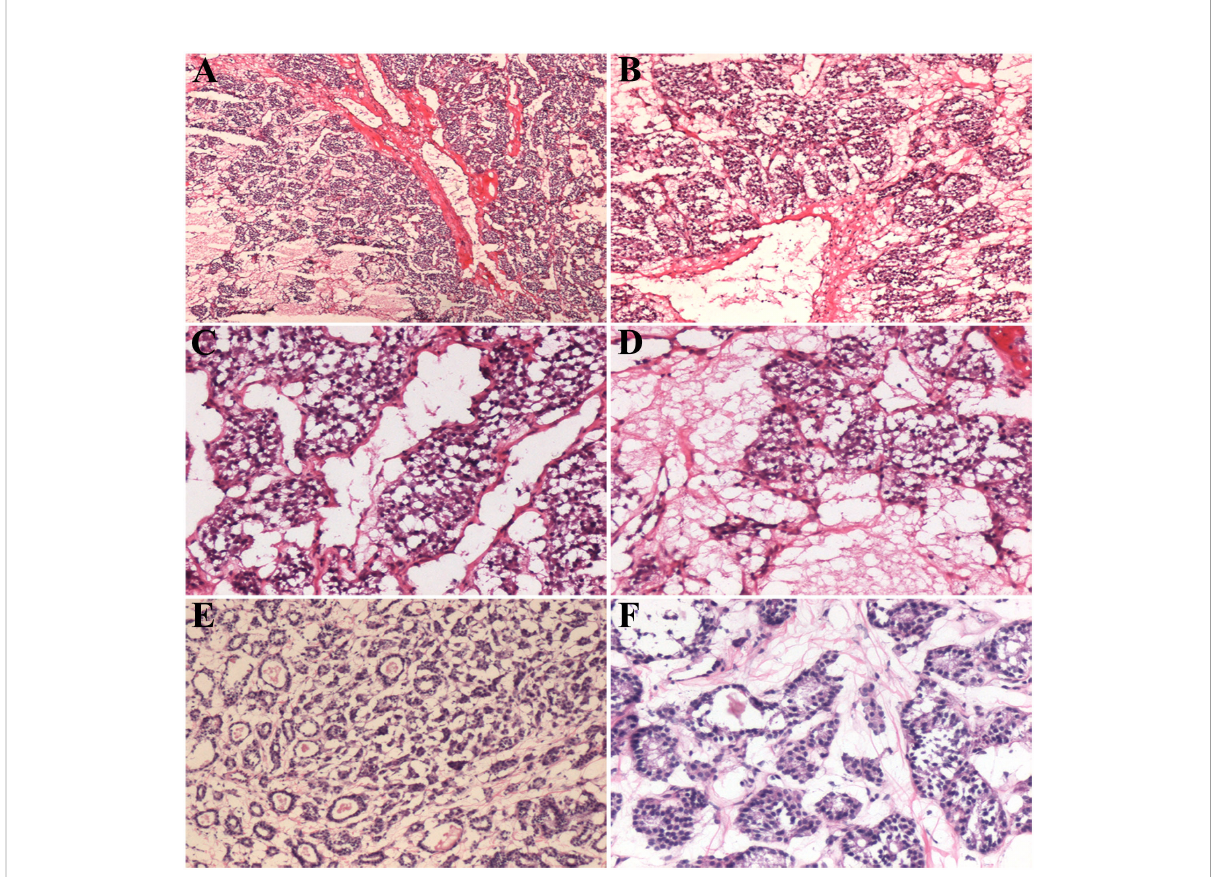
FIGURE 2 Histological features of the intraoperative frozen sections of thyroid paraganglioma (A – D) and follicular adenoma (E, F) . Scale bars: 400 m m (A, B) , 200 m m (C, D) , 300 m m (E) , and 100 m m (F)